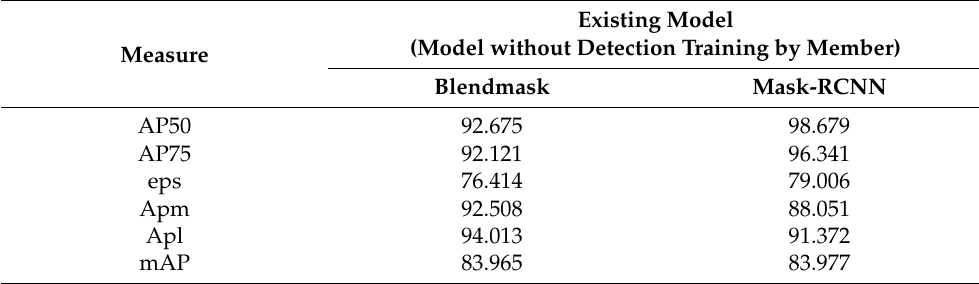
Table 8. Damaged-object-detection performance results for member specific models.